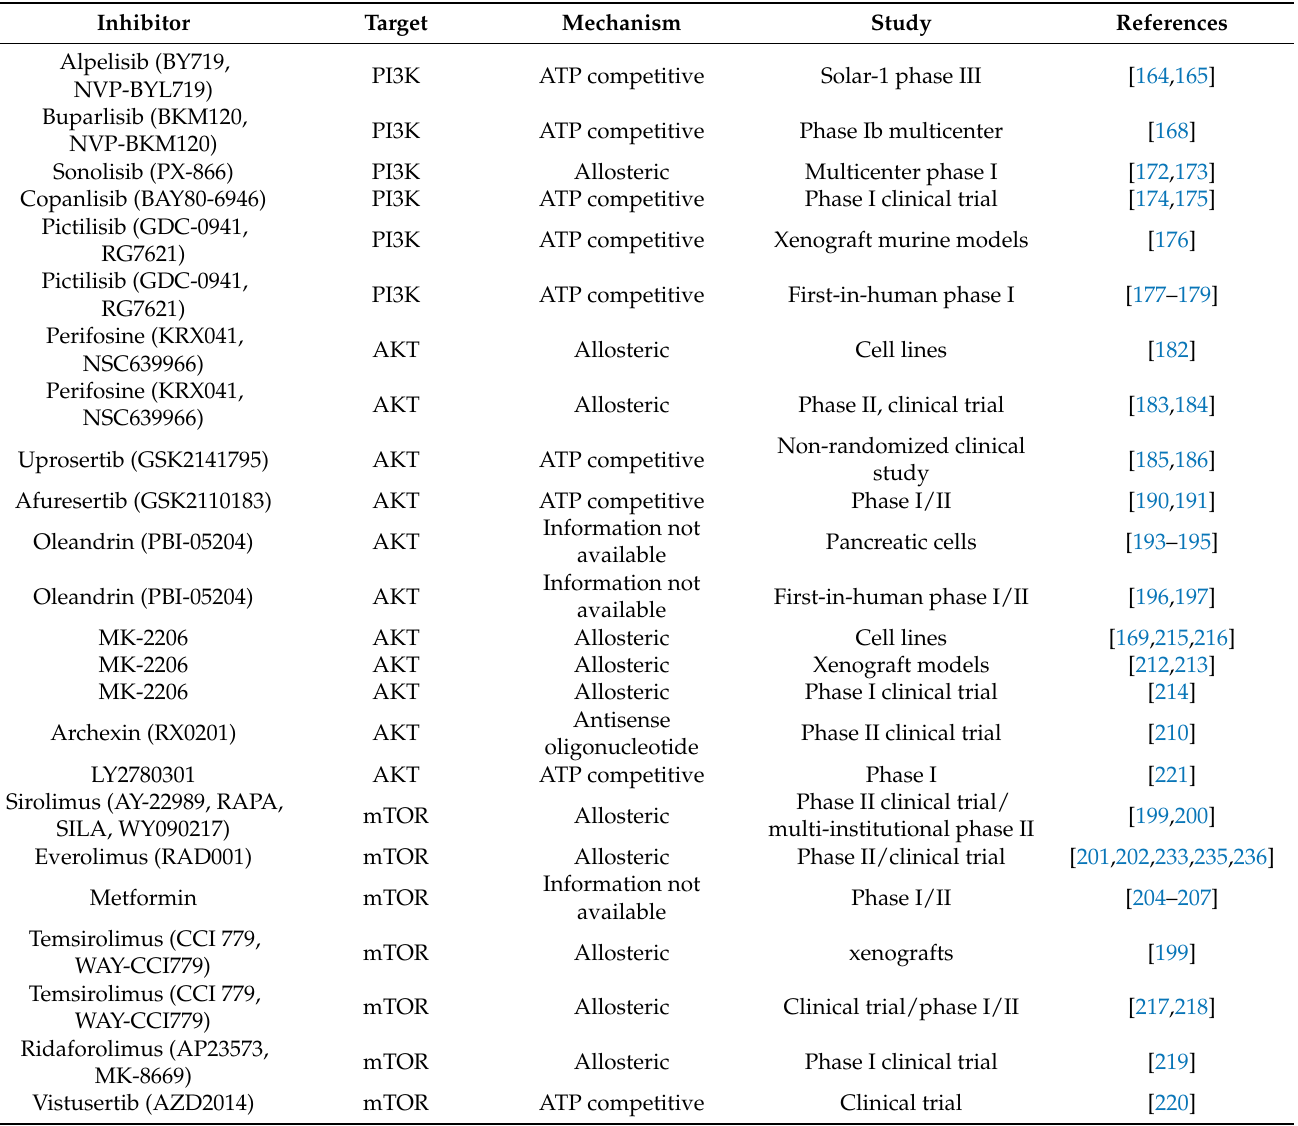
Table 1. PI3K/AKT/mTOR inhibitors used in pancreatic cancer